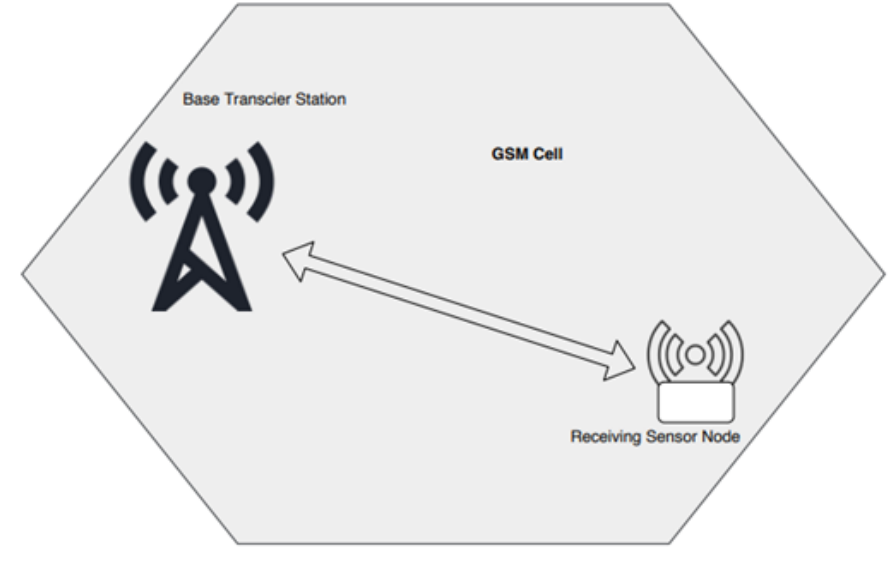
Figure 1. GSM sensor node, in a GSM